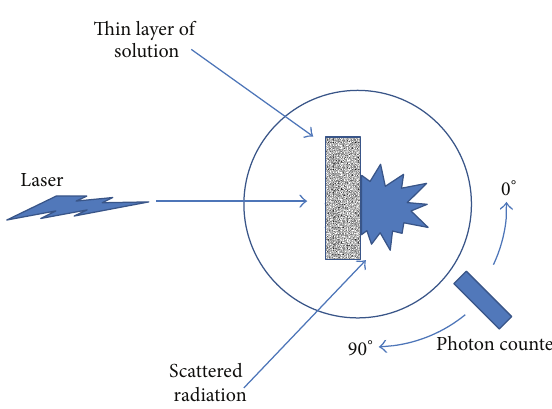
Figure 2: Scattering indicatrix measurement setup. Laser wave- length is 632.8